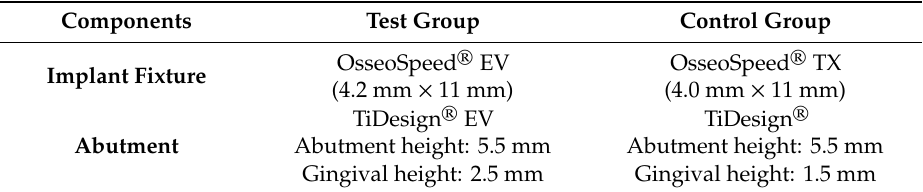
Table 1. Materials used in this study. All fixtures and abutments were composed of commercially pure grade 4 titanium.